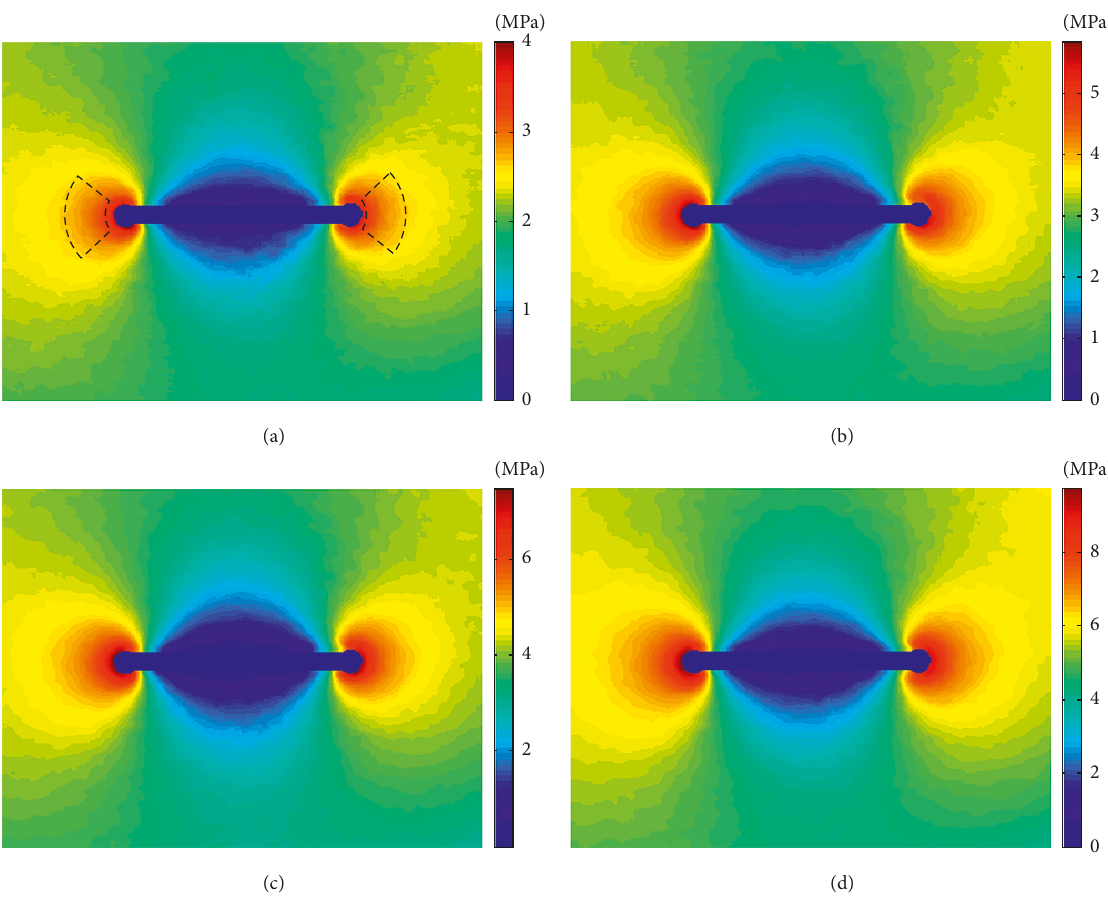
Figure 6: The sum of stress ( σ x + σ y ) in the PMMA specimen with a crack. (a) σ 00 (cid:29) 1 MPa, (b) σ 00 (cid:29) 1.5MPa, (c) σ 00 (cid:29) 2MPa, and (d) σ 00 (cid:29)